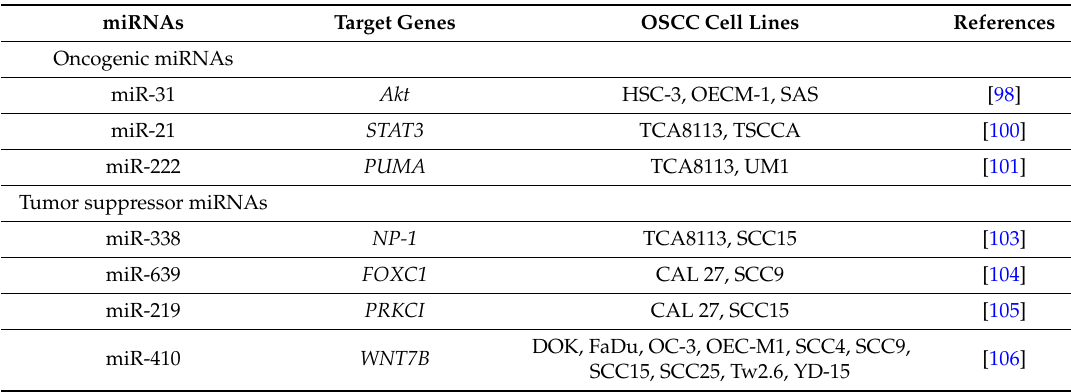
Figure 1. The predicted protein–protein interaction for the tumor suppressor oncogenic microRNA (miRNA) targets in Table 2. This network was constructed using STRING version 10.5 [102]. All the protein symbols carry the official name of HUPO. Proteins encoded by tumor suppressor miRNAs targets in Table 2 do not have any boxes, i.e., ERRRA, NRP1, IGF1R, DKK2, PRKCI, EGFL7, HSPH1, HSP90AA1, WNT7B, FOXC1, GIT1, and CXCR4. Ten proteins within the dash-lined box (SUGT1, CDC37, PTGES3, STIP1, AHSA1, PARD6A, TTC28, SUGT1P3, TTC12, and TTC31) indicate the predicted functional partners connecting to the proteins encoded by tumor suppressor miRNAs targets. Only EFGL7 is unable to find the possible interacting proteins under the current version of STRING. The meanings associated with each of the colored lines are the same as mentioned in STRING, including (1) known interaction from curated databases or experimentally determined, (2) predicted interactions from gene neighborhood, gene fusion, or gene co-occurrence, and (3) others (text mining, co-expression, or protein homology). In brief, proteins with lines connecting to others indicate the existence of possible interactions. Table 2. miRNAs and their target genes in oral cancer cells.